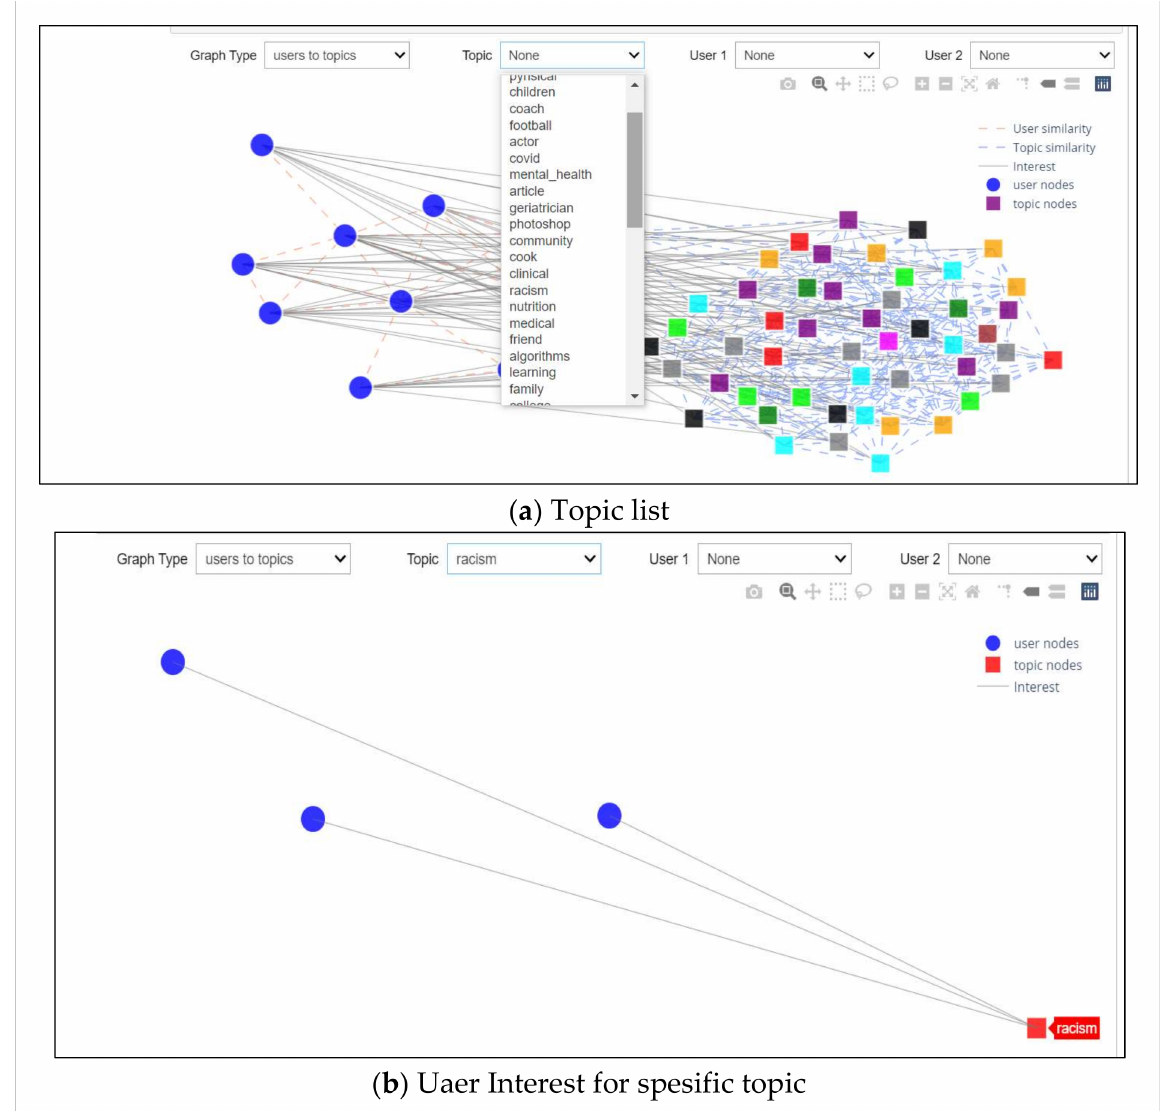
Figure 14. Interest Topic